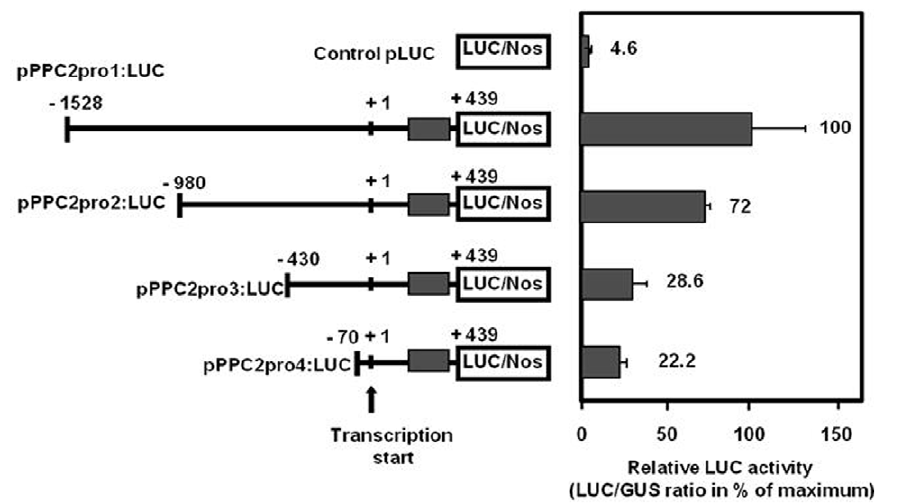
Figure 4. Transient reporter-gene expression analysis of SlPPC2 promoter deletions in 8 daa tomato fruit. Slices from 8 daa fruit («WVa 106» cherry) were transformed by biolistic with a 35S:GUS plasmid co-delivered with SlPPC2 promoter:LUC fusion plasmids (pPPC2pro1-4:LUC construct; sizes in nucleotides from the transcription start indicated; grey box indicates leader intron).The pLUC plasmid (promoterless LUC construct) was used as a negative control. Data were normalized using the 35S:GUS construct as internal standard and are expressed as % of maximum activity (pPPC2pro1:LUC construct). The mean values and SE of 6 to 12 independent transformations are shown.